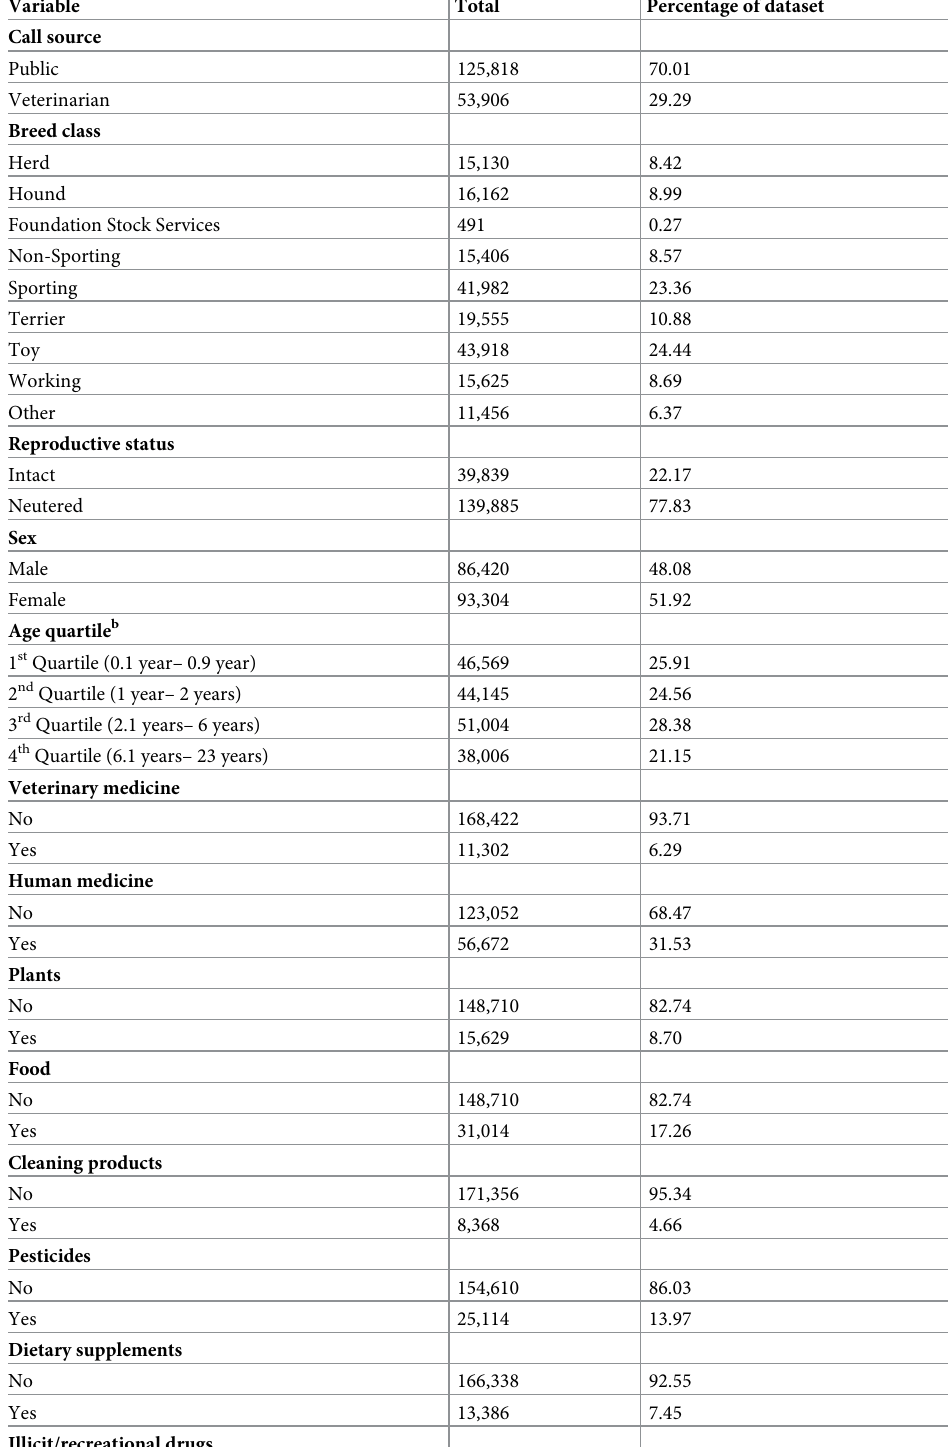
Table 1. Descriptive statistics concerning the source of calls and the characteristics of the dogs, availability of vet- erinary services, type of toxicants, and season from calls made to the APCC concerning poisoning events in pet dogs from the US (2005–2014) �